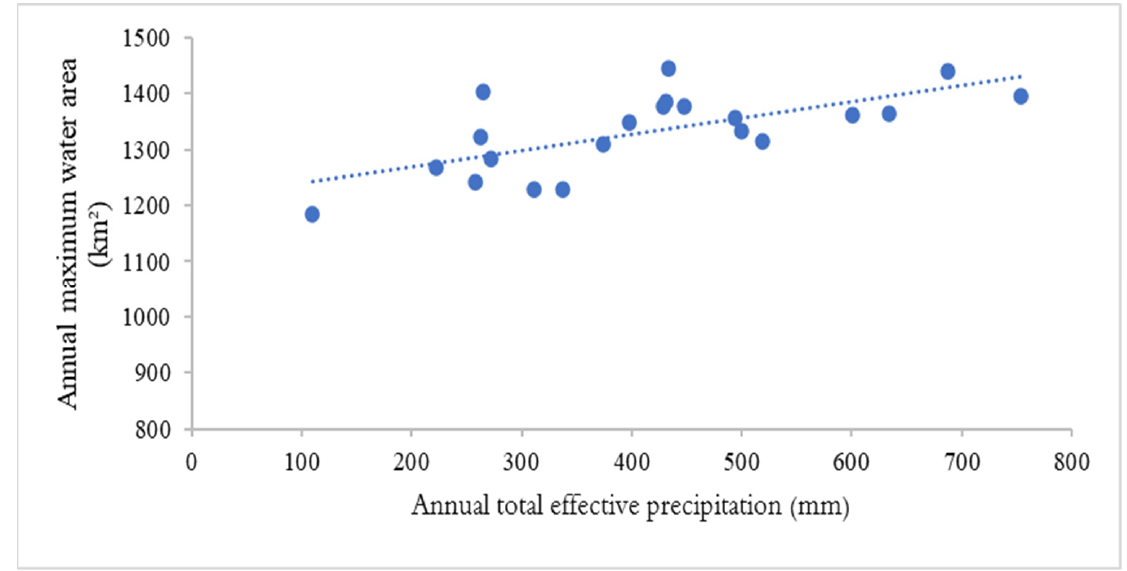
Figure 13. Linear regression analysis of the annual total effective precipitation and annual maximum water area of the three Dongting Lake wetland reserves from 2000 to 2020.